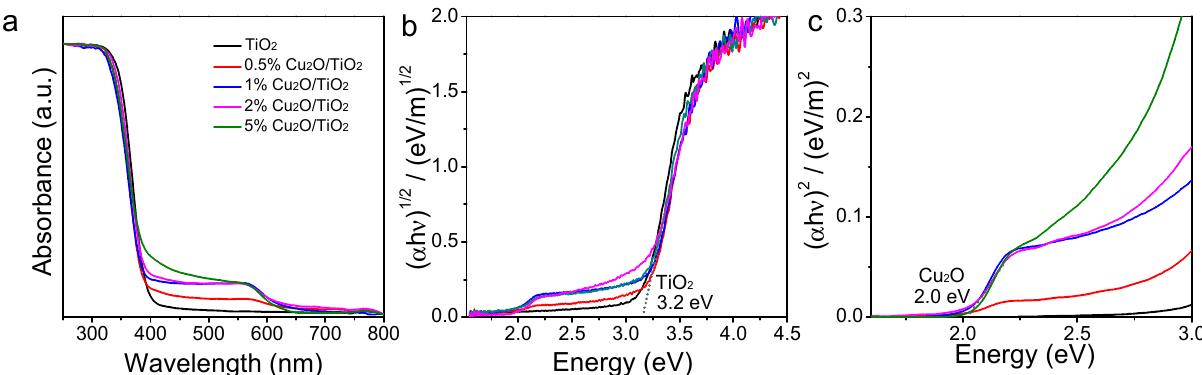
Figure 2. UV-vis absorption spectra ( a ) and Tauc plot calculated as ( α h ν ) 1/2 vs. h ν ( b ) and as ( α h ν ) 2 vs. h ν t ( c ) for TiO 2 and 0.5%, 1%, 2% and 5% Cu 2 O/TiO 2 nanocomposites.